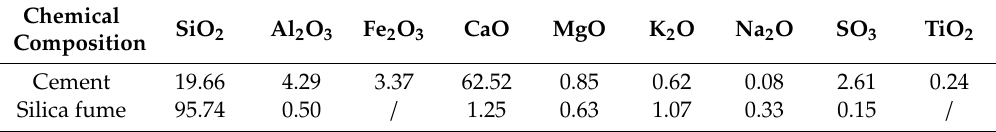
Table 1. Chemical composition of raw materials